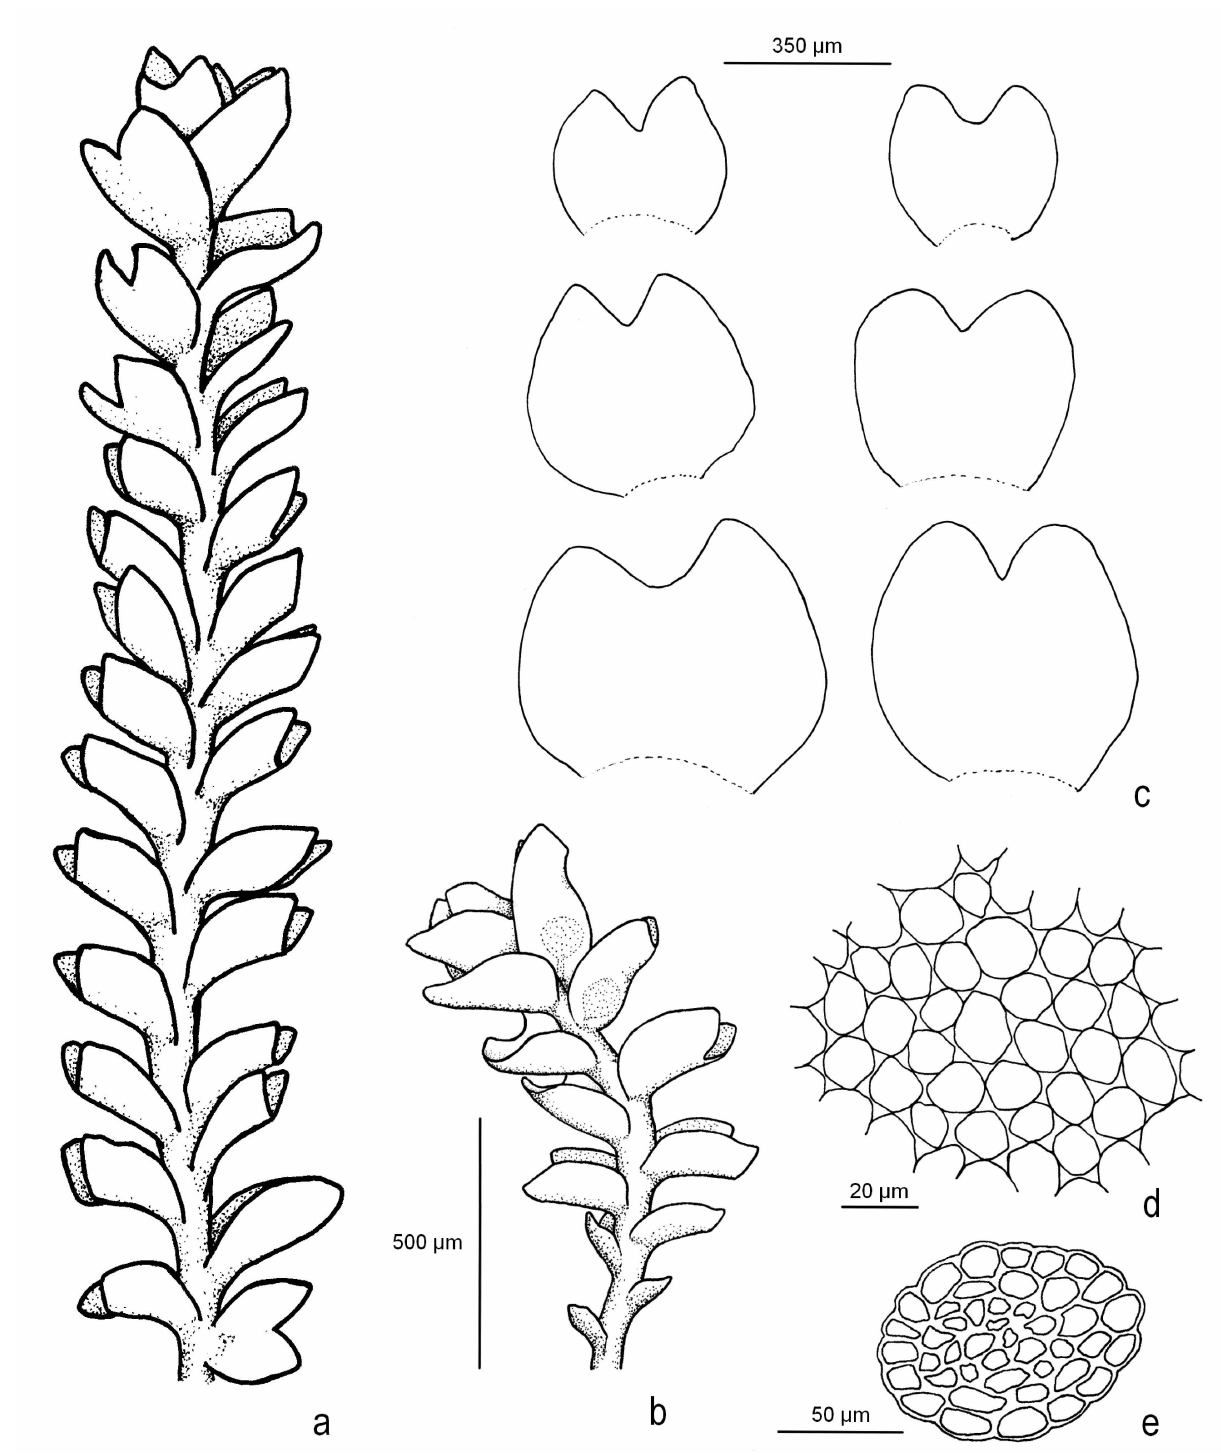
Figure 2. Marsupella lusitanica R.D. Porley & Jan Kuˇcera (all from Porley s.n. , paratype 5): ( a ) sterile shoot, wet; ( b ) male plant, wet; ( c ) leaves; ( d ) cells in mid-lobe region; ( e ) cross-section of stem. Line drawing by Nick